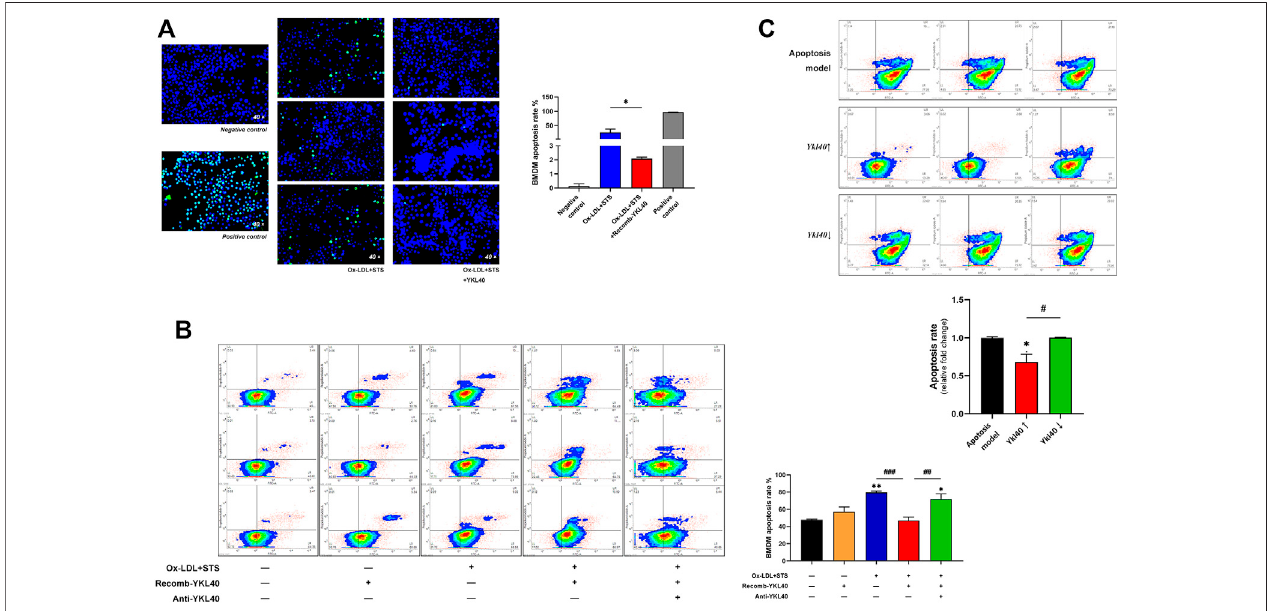
FIGURE5|(A) TUNELdetectionperformedonBMDM.TheapoptosisrateofBMDMtreatedbyYKL-40recombinantproteinwassigni fi cantlylowerthanthatinthe apoptosis model that treated by Ox-LDL accompanied by staurosporine ( p (cid:1) 0.0161). (B) FCM indicated the apoptosis rate of BMDM was signi fi cantly lower in the recomb-YKL-40 group than that in apoptosis model group ( p (cid:1) 0.0008), as well as that in anti-YKL-40 group ( p (cid:1) 0.0042). (C) FCM indicated the apoptosis rate of RAW264.7 was signi fi cantly lower in the Ykl40 ↑ group than that in apoptosis model ( p (cid:1) 0.0205) and Ykl40 ↓ group ( p (cid:1) 0.0197).